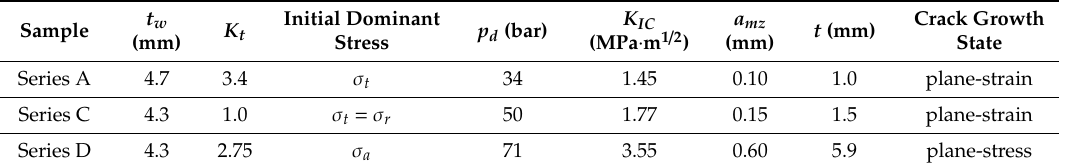
Table 1. Geometrical, strength and fracture-mechanical characteristics of destructive pressure-tested water-filter